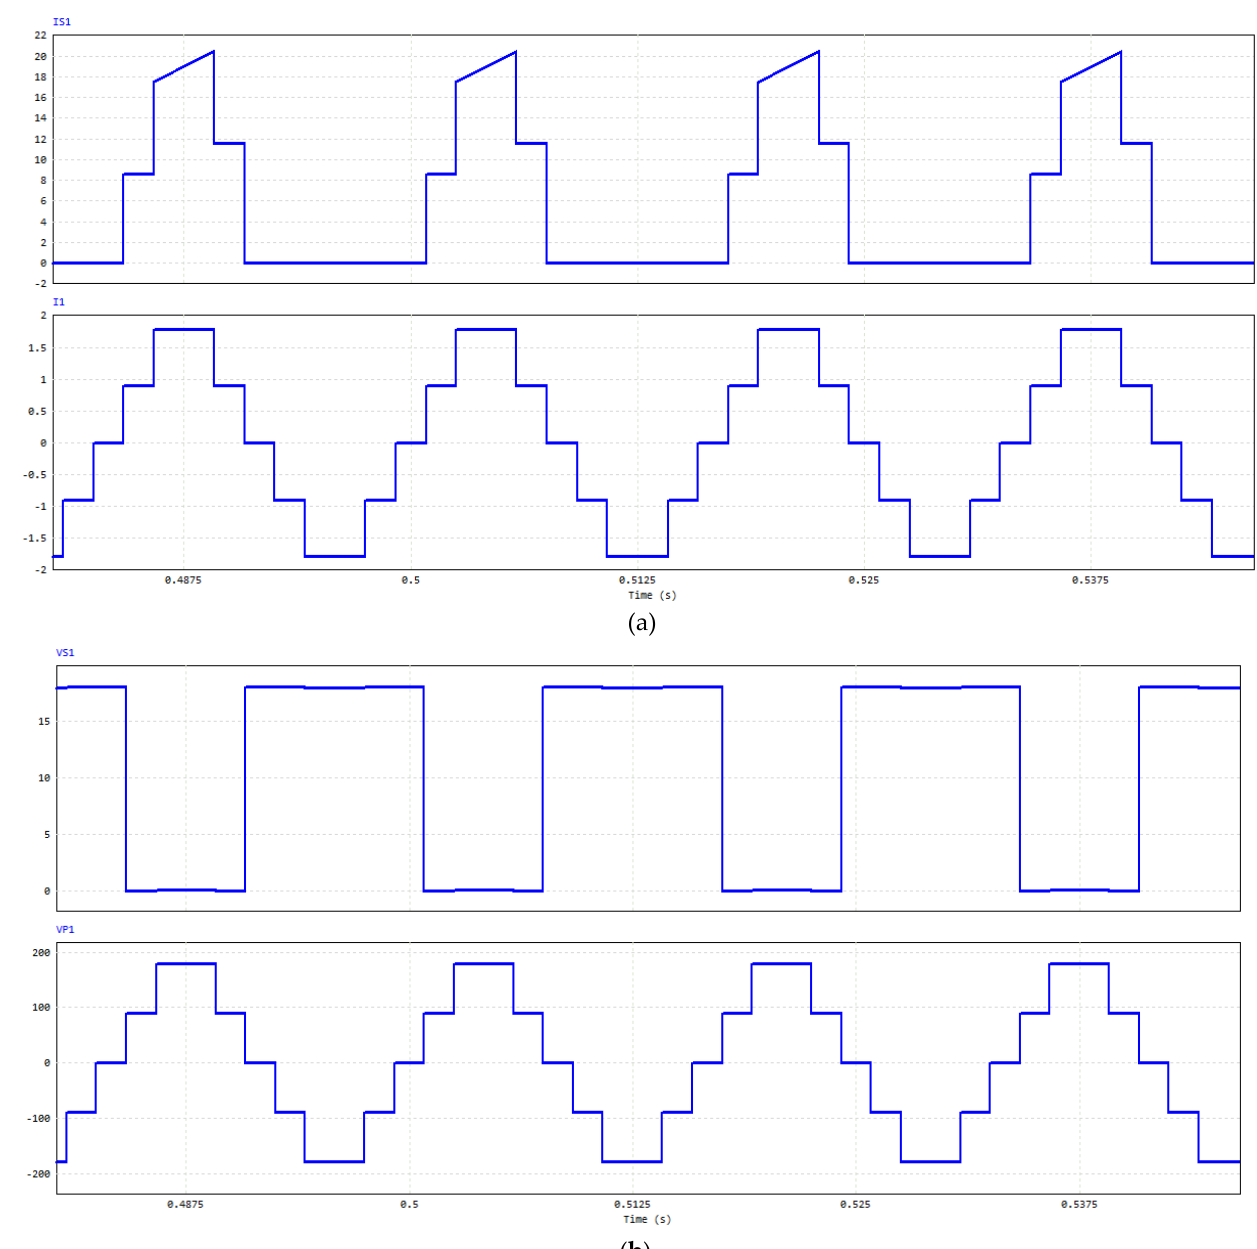
Figure 25. Semiconductor ’ s waveforms: ( a ) the current through switch S 1 compared to the output current, and ( b ) the voltage across switch S 1 compared to the output voltage.